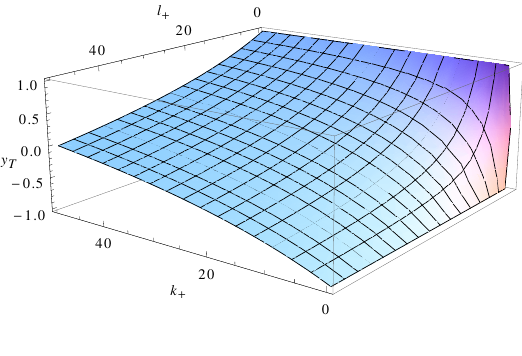
Figure 13 . Manifold where the double-cut integrals with triple-gluon vertex become divergent. It corresponds to the limit of the two gluons k and l becoming collinear to each